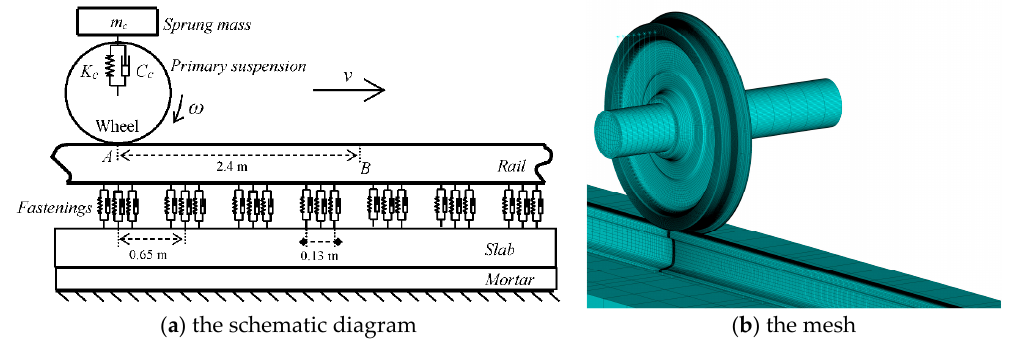
Figure 7. 3D wheel/rail rolling contact fine element model.